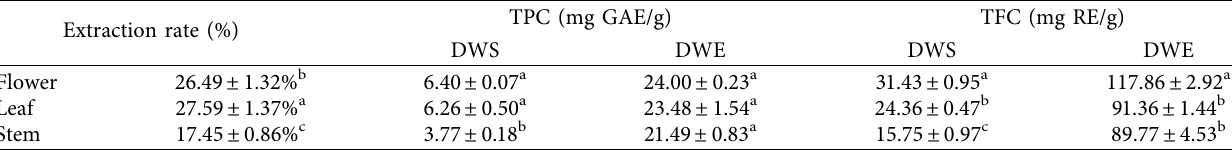
Table 1: Total phenolic contents (TPCs) and total flavonoid contents (TFCs) in the flower, leaf, and stem of Prinsepia utilis Royle.